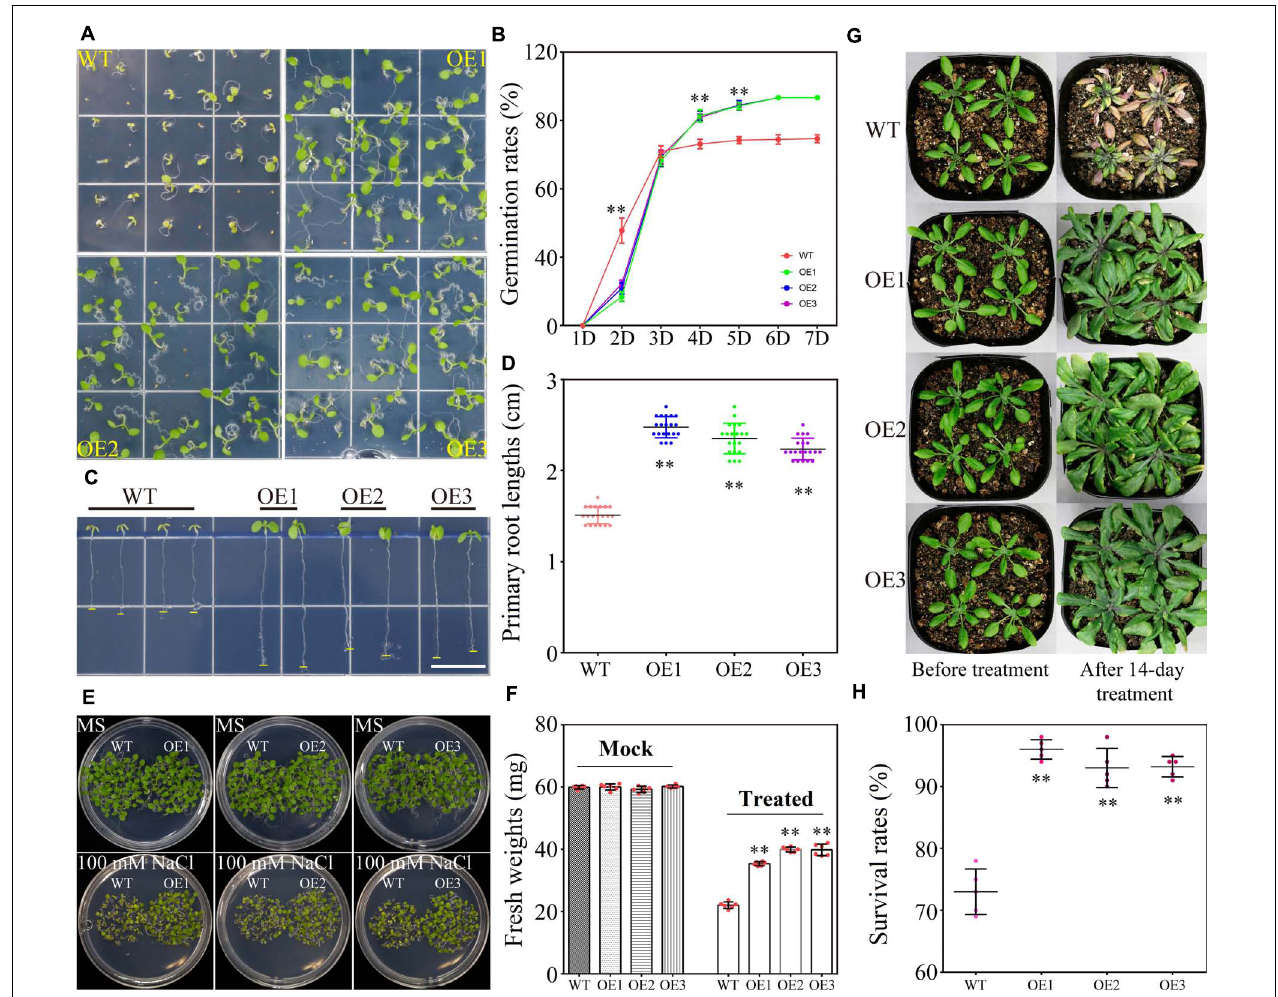
FIGURE 7 | Overexpression of TaWRKY75-A increases salt tolerance in transgenic Arabidopsis . (A) Observations of seed germination in wild type (WT) and OE lines at 1 week after germination. (B) Seed germination rate of WT and OE lines within a week. One-way ANOVA followed by Tukey honest significant difference (HSD) test was performed. ∗∗ p < 0.01. Bars indicate means ± SD. This experiment was replicated five times. (C) Observation of primary root elongation of WT and OE lines during 7 days after germination. Scale bar: 1 cm. (D) Quantification of primary root lengths of WT and OE lines at 7 days after germination. One-way ANOVA followed by Tukey HSD test was performed. ∗∗ p < 0.01, n = 20. Bars indicate means ± SD. (E) Observations of the growing status of WT and OE seedlings under normal and salt conditions at 7 days after germination. (F) Quantification of fresh weight of 50 seedlings of WT and OE lines under normal and salt conditions at 7 days after germination. One-way ANOVA followed by Tukey HSD test was performed. ∗∗ p < 0.01. This experiment was replicated five times. (G) Observations of WT and OE seedlings during salt stress. The salt stress was applied for 2 weeks. (H) Quantification of the survival rate of WT and OE lines after 2 weeks of salt treatment. One-way ANOVA followed by Tukey HSD test was performed. ∗∗ p < 0.01. Bars indicate means ± SD. This experiment was performed five